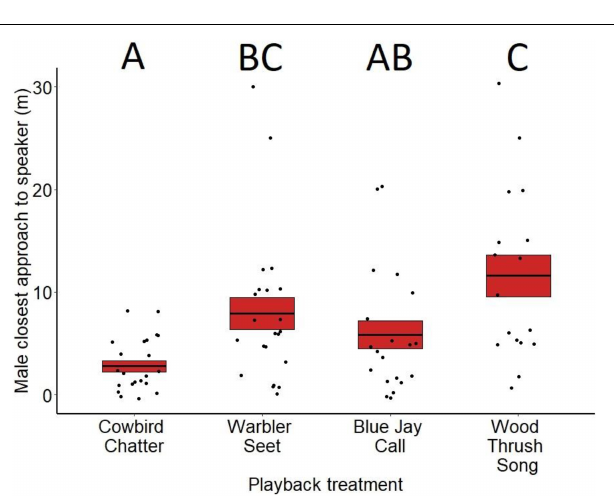
FIGURE 3 | Closest approach to the playback speaker (in meters) by male red-winged blackbirds for the different treatments at nests during nestling stage. Means are shown with the bold line, and shaded boxes represent standard errors. Boxes with different letters denote post hoc statistical differences between treatments. For the p -values of post hoc comparisons, please refer to Supplementary Table 2 .